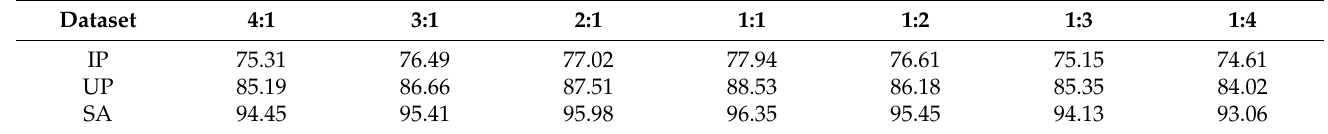
Table 3. Classification performance of different fusion ratios (OA, Training sample = 10).